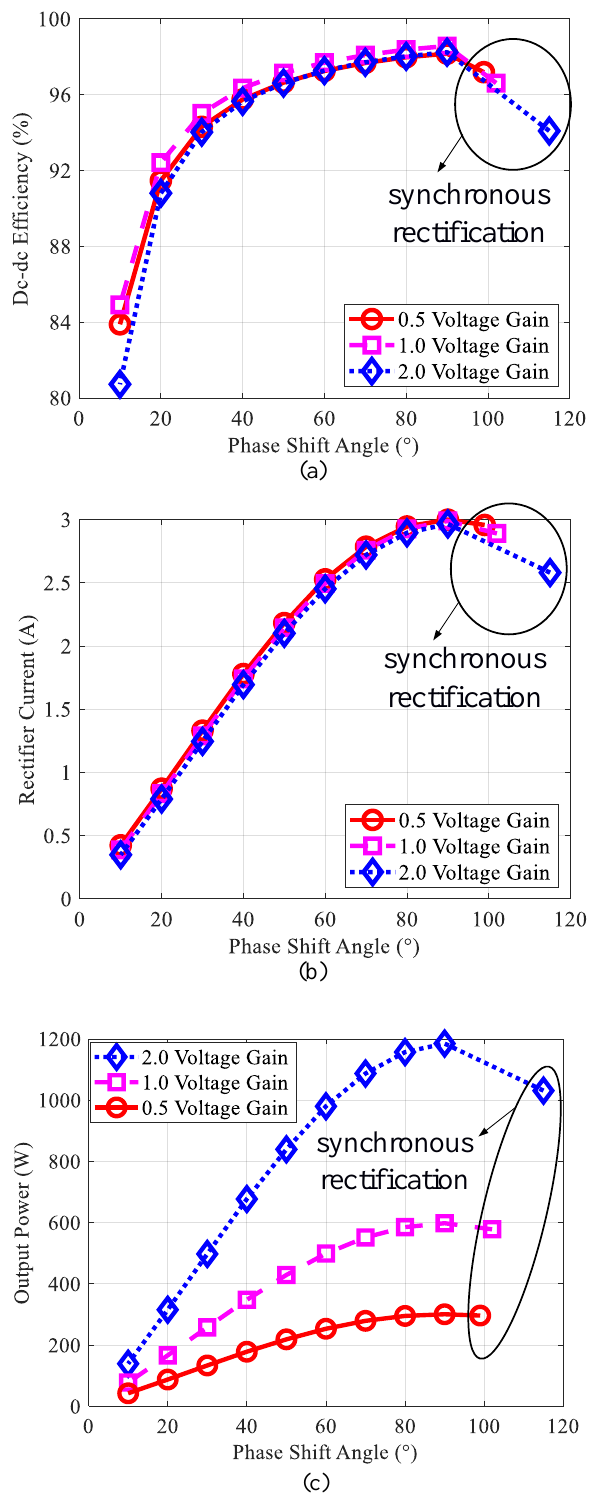
Figure 8. ( a ) Measured dc-dc efficiency, ( b ) rectifier current, and ( c ) output power under three voltage gains.